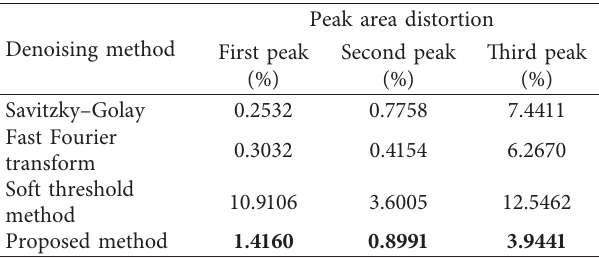
Figure 11: Effect of different methods on signal denoising with concentration of 0.1 mM. (a) Savitzky–Golay. (b) Fast Fourier transform. (c) Soft threshold method. (d) Proposed method. Table 3: Peak area distortion after denoising by different